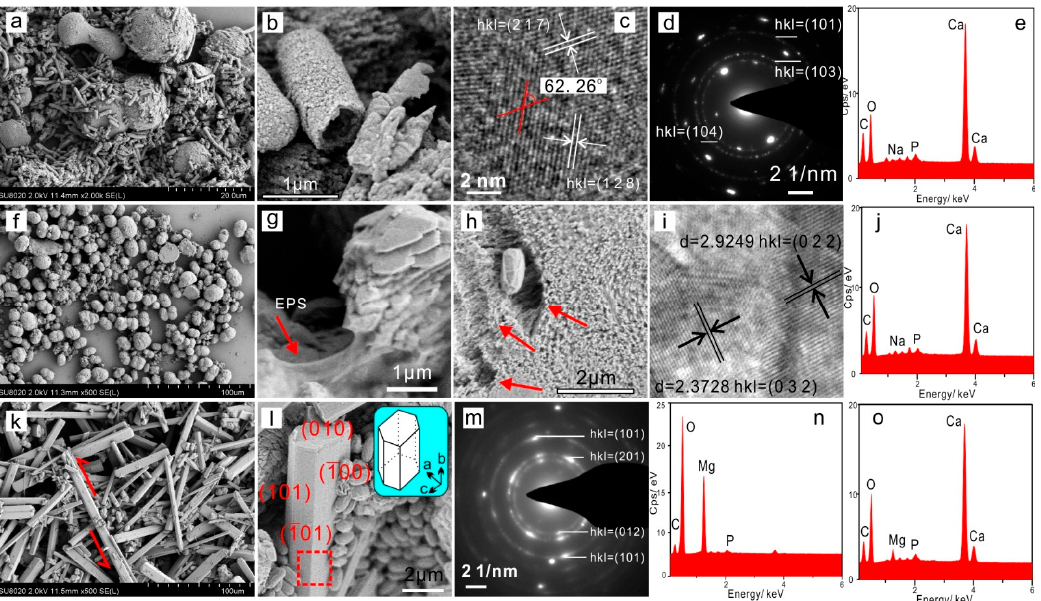
Figure 6. Scanning electron microscope, energy spectrum, high resolution transmission electron microscope, and selected area electron di ff raction images of the minerals cultured for 12 days in the experimental groups at Mg / Ca ratios of 0 ( a – e ), 6 ( f ), 8 ( g – j ), 10 ( k ), and 12 ( l – o ). At Mg / Ca ratios of 6 and 8, the minerals were ellipsoid-shaped monohydrocalcite (100%,